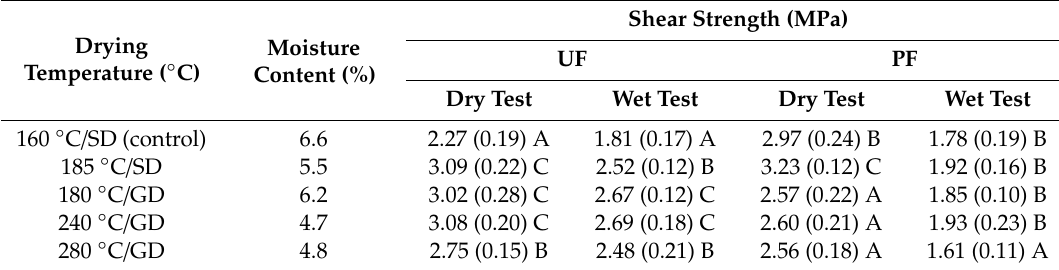
Table 3. Shear strength of plywood